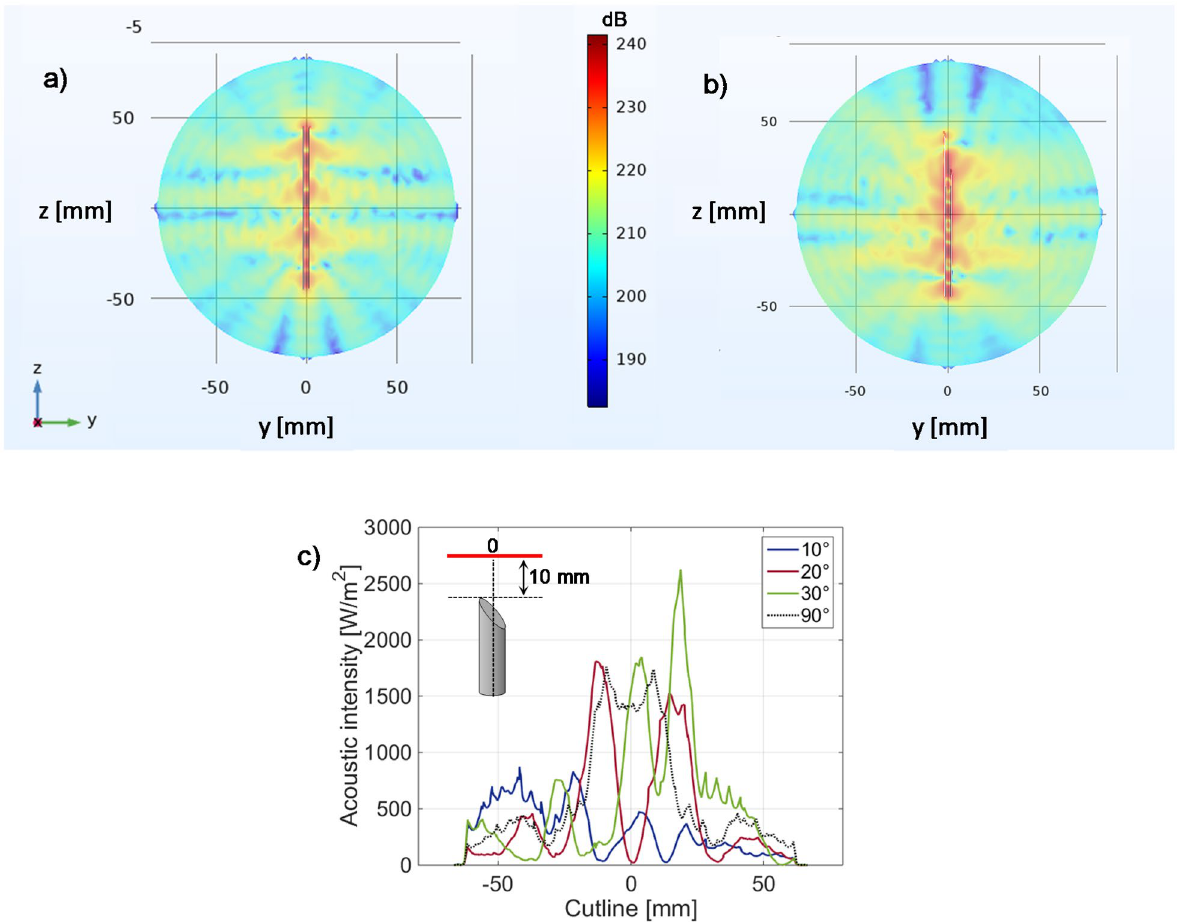
Figure 7. Sound pressure level in the y–z plane of symmetry of the needle in the case of flat tip ( a ) and 10° beveled ( b ). ( c ) Acoustic intensity profiles evaluated along a cutline orthogonal to the needle longitudinal direction, 10 mm distant from the needle tip, and lying in the y–z plane of symmetry. The length L is 70 mm, the diameter D is 3 approximately 20 dB at a distance of 10 mm from the needle center. The introduction of a sharpen tip (Fig. 7b), as expected, breaks this symmetry, and the antinodes of the stationary waves ‘deflect’ in correspondence of the needle tip. Obviously, this asymmetry affects the intensity coming out from the needle tip, as already discussed (Fig. 6c). To better understand this aspect, the acoustic intensity was evaluated along a cutline orthogonal to the needle longitudinal direction, lying in the needle plane of symmetry, and placed at a distance of 10 mm from the needle tip (results plotted in Fig. 7c). More specifically, the acoustic intensity profiles evaluated at bevel angles of 10°, 20° and 30° (blue, red and green solid lines, respectively) are compared with those pertaining to the flat tip (black dashed curve). The intensity profile pertaining to the needle with a flat tip appears symmetrical with respect to the needle center. In particular, it assumes a value of approximately 1420 W/m 2 at the center, with an overelongation of approximately 300 W/m 2 at a distance of ~ 8 mm, and then decreases, reaching a value of approximately 170 W/m 2 at ~ 30 mm. When the tip is sharpened, the central lobe is split into more lobes of different intensities. More specifically, when α is 30°, three lobes can be clearly distinguished in the profile evalu- ated at 1 mm distant from the needle tip. The central one is almost located at the needle center and assumes a value of 1850 W/m 2 , while the higher one is at the right side, at a distance of approximately 19 mm from the center, and reaches 2625 W/m 2 . With α = 20°, the main lobes become 2, one at − 12 mm of 1785 W/m 2 and one at 14 mm of 1524 W/m 2 . When the tip becomes sharper and the angle reaches a value of 10°, a maximum of 817 W/m 2 is reached at approximately − 20 mm, and the other three lobes of a slightly lower intensity are visible along the profile. Overall, these results demonstrate that a medical needle can be effectively used for transmitting ultrasound waves inside soft tissues at frequencies on the order of 100 kHz. The acoustic intensities irradiated depend on the needle geometrical characteristics and can be optimized (taking into account the constraints imposed by the invasiveness of the final device), reaching values in the range of 1000 W/m 2 (at a distance of 10 mm) in the case of a displacement of 1 µm applied at the needle base, considered completely inserted in infinitely extended soft tissue. Specifically, the bevel angle strongly influences both the intensity and the propagation direction of the acoustic wave inside the tissue, which results mainly oriented orthogonally to the needle tip cut.